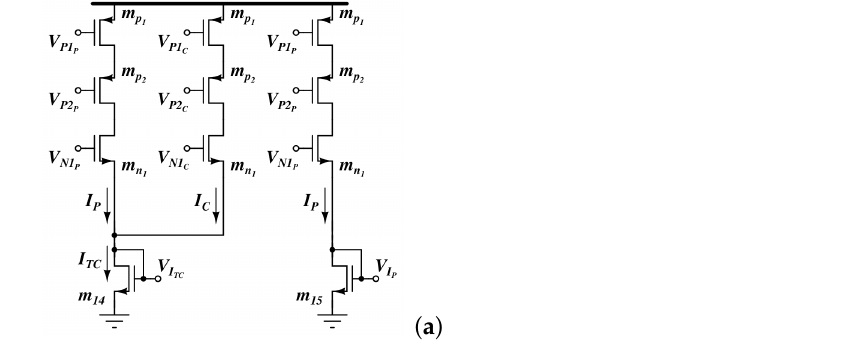
Figure 7. Current and voltage reference. ( a ) Current reference. ( b ) Voltage reference.